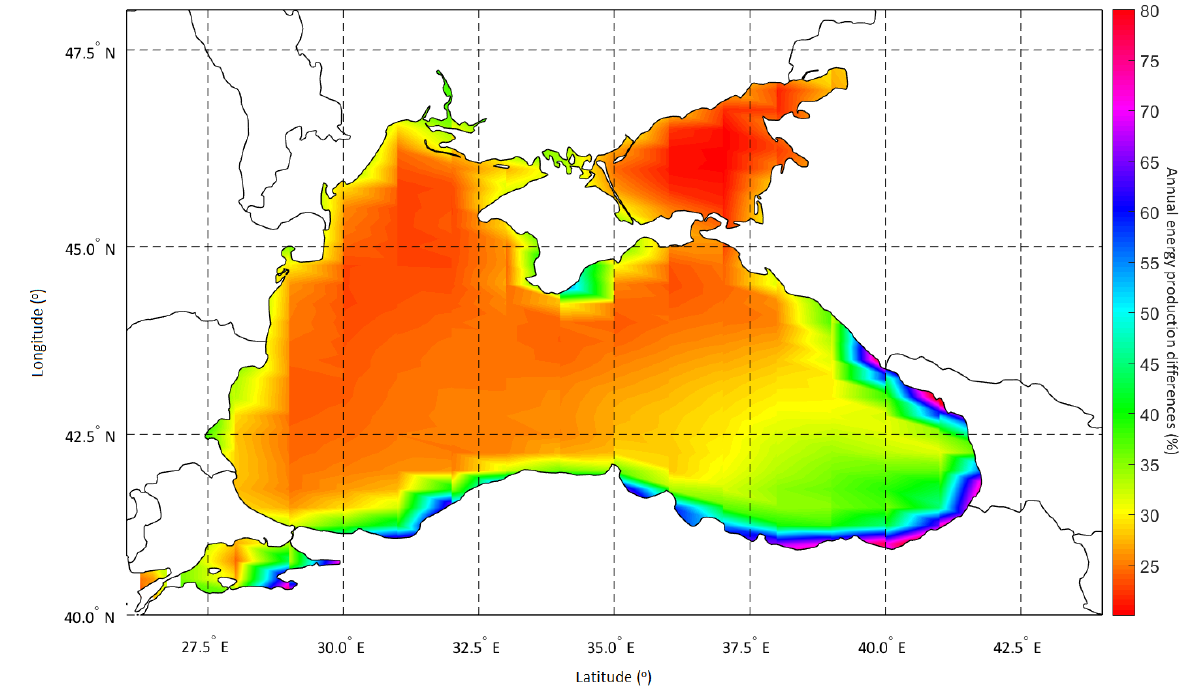
Figure 14. Differences (in %) reported between the expected AEP of a wind turbine and AWES system (U200) defined by a rated capacity of 5 MW.